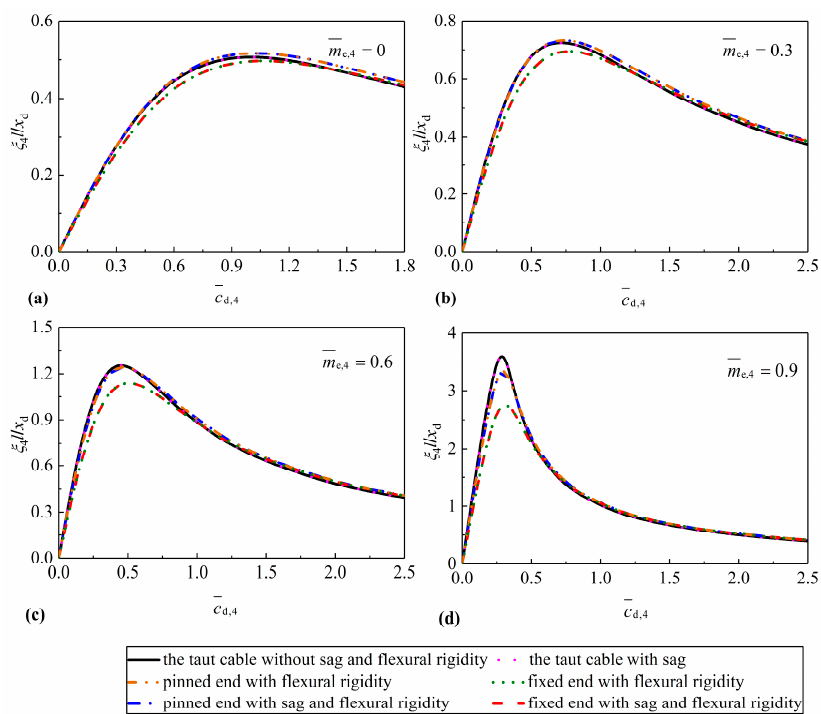
Figure 15. The fourth supplemental modal damping ratio of the long cable versus damping coefficient for various inertial masses: ( a ) m e,4 = 0; ( b ) m e,4 = 0.3; ( c ) m e,4 = 0.6; ( d ) m e,4 =